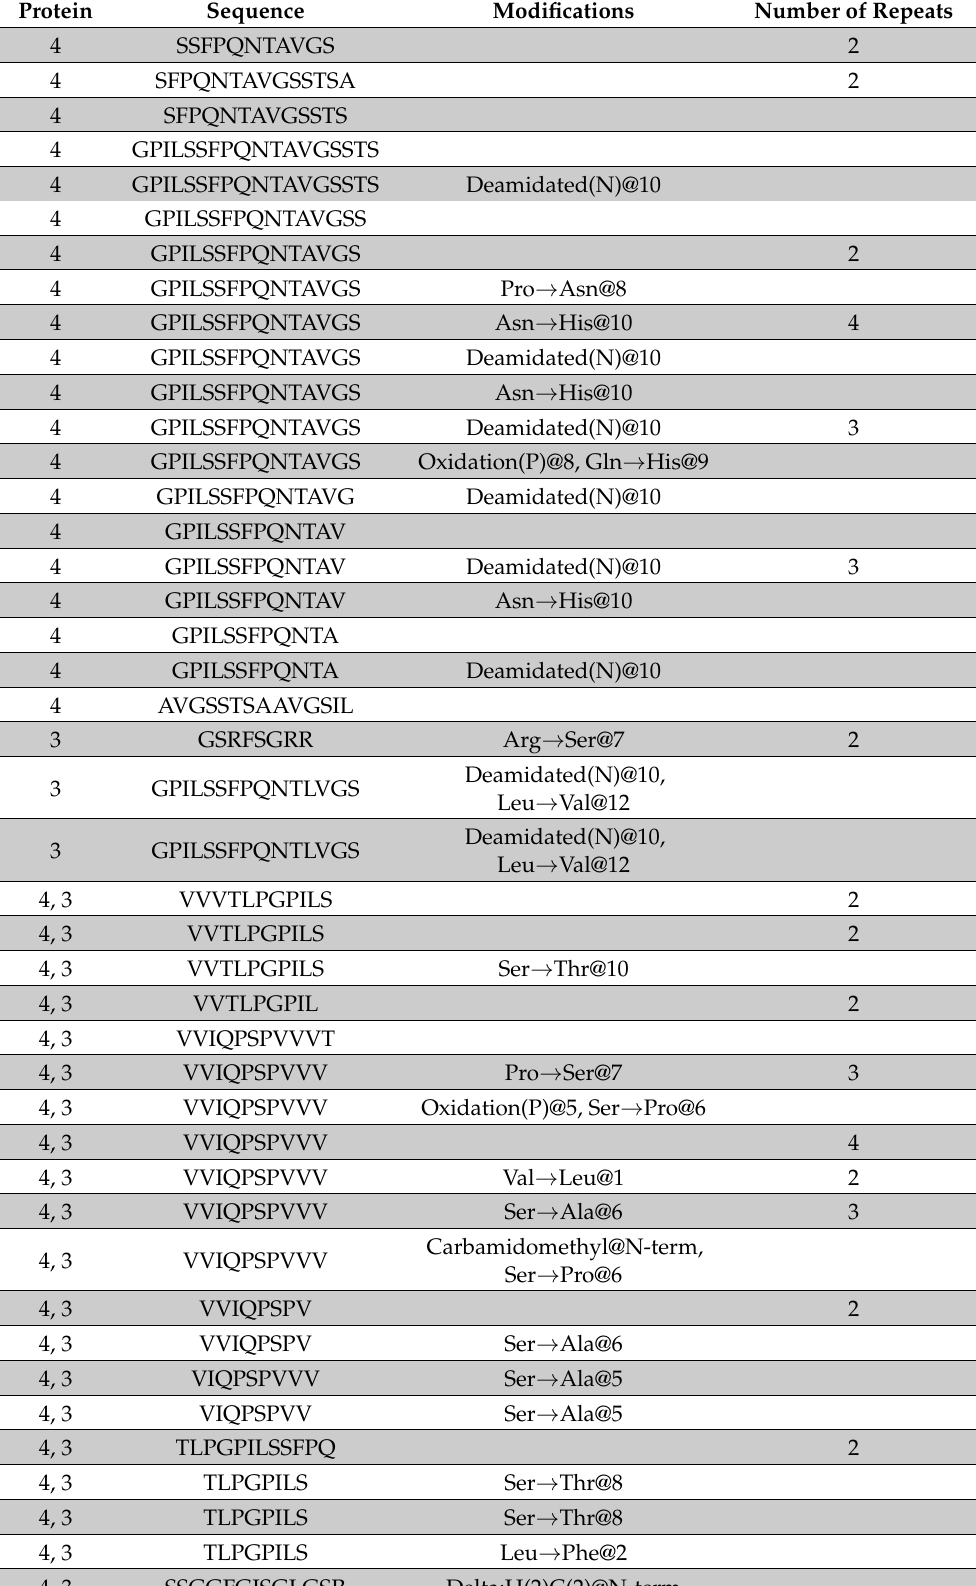
Table 3. Peptide sequence of the chicken feather microbial degradation present in the fraction P188D 20% with 99% of confidence and its homology to chicken feather keratin 3 and